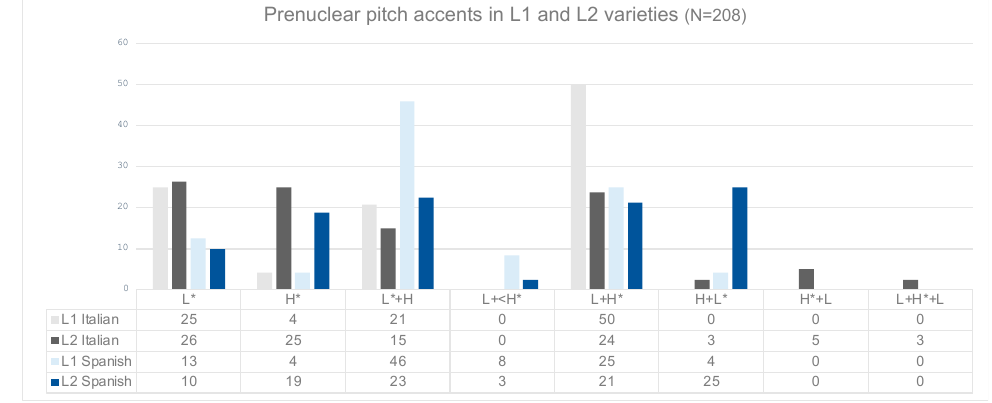
the two monotonal patterns H* (25%) and L+H* (24%) ( χ 2 :(6) = 29,012; p < 0.001; for all tonal realizations in the prenuclear position). With a few exceptions, the learners diverged from the target languages in this position; the difference was significant between the L1 and L2 Italian varieties (Fisher’s exact test; p = 0.019), as well as between the two Spanish groups (Fisher’s exact test; p = 0.025). 6